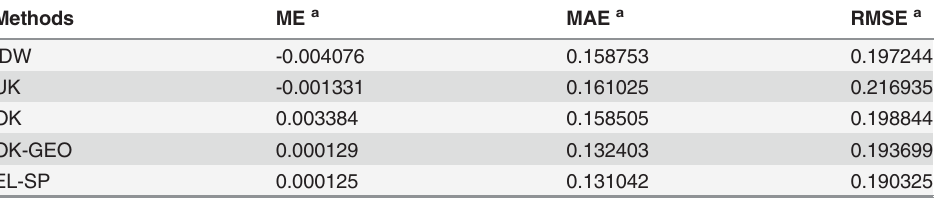
Table 2. Comparisons of the accuracy among the UK, OK, IDW, OK-Geo, and EL-SP methods.